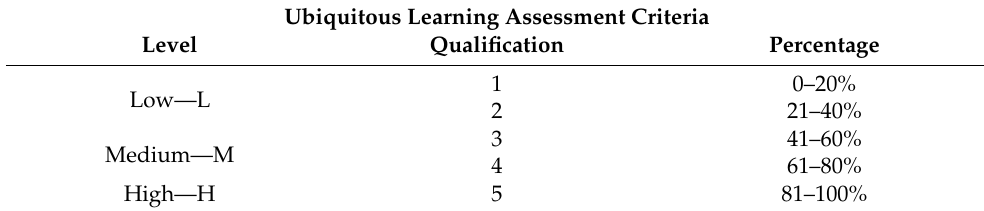
Table 3. Levels, Criteria, and Percentage of the U-CLX Model